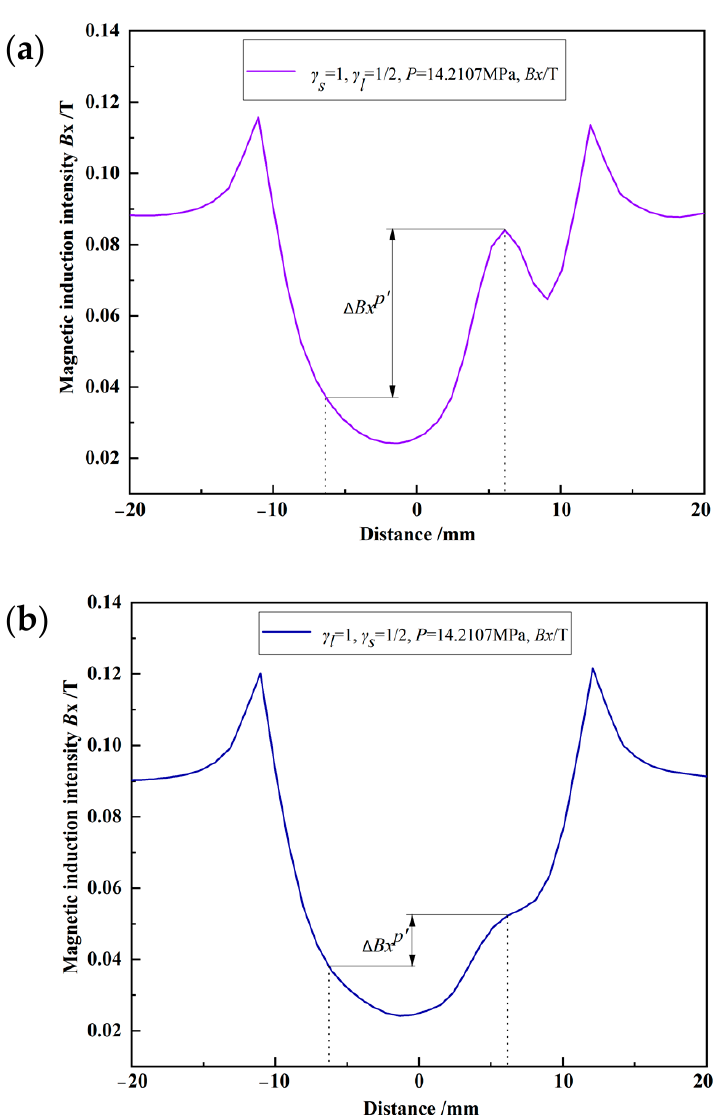
Figure 19. Schematic diagram of ∆ Bx p (cid:48) in the third set of the examples. ( a ) γ s = 1, γ l = 1 ( b ) γ l = 1, γ s = 1